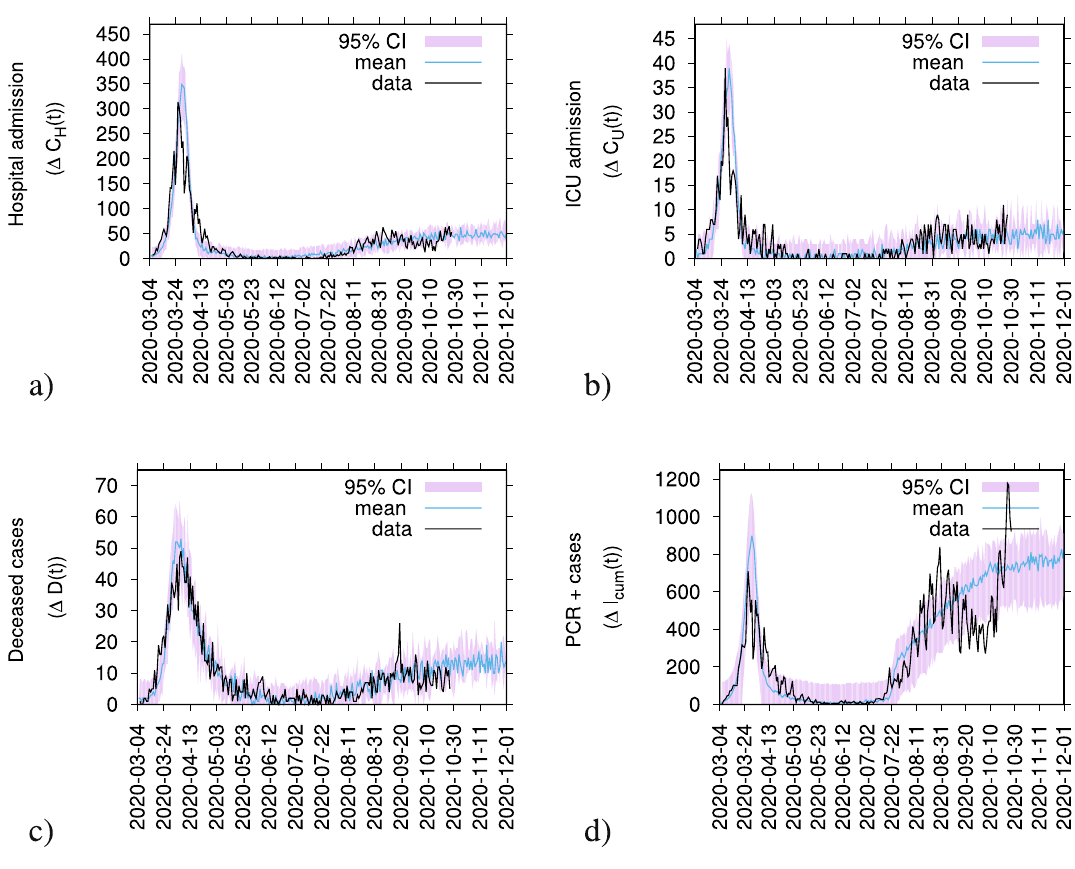
Figure 4. COVID-19 incidences in the Basque Country, from March 4 to October 27, 2020. In ( a ) hospital admissions, in ( b ) Intensive Care Units (ICU) admissions, in ( c ) deceased cases and in ( d ) detected positive cases via PCR tests). Data are plotted as black lines. The mean of 200 stochastic realizations for the SHARUCD model are plotted as a blue line, from March 4 to November 21, 2020, showing a stationarity behavior of the incidences. The 95% confidence intervals are obtained empirically from the stochastic realizations and are plotted as purple